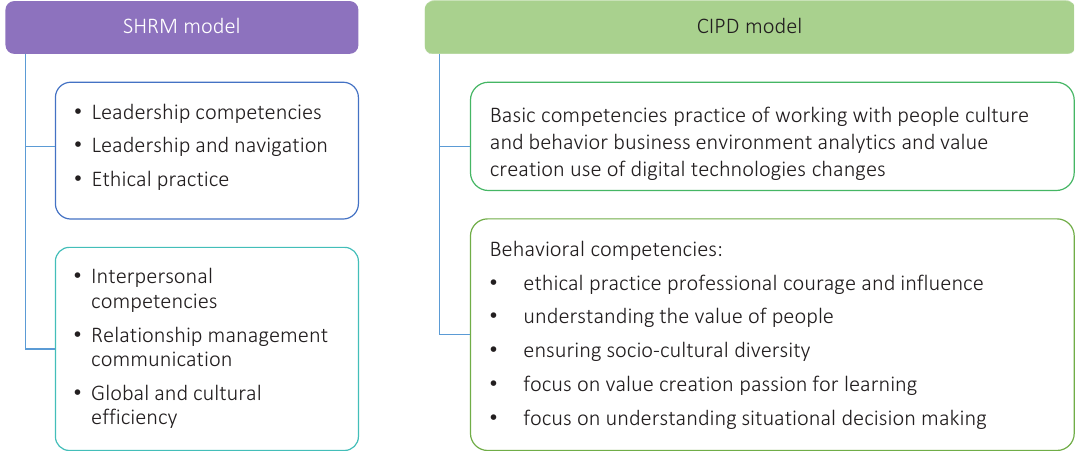
Figure 2. Transferal competencies of personnel managers according